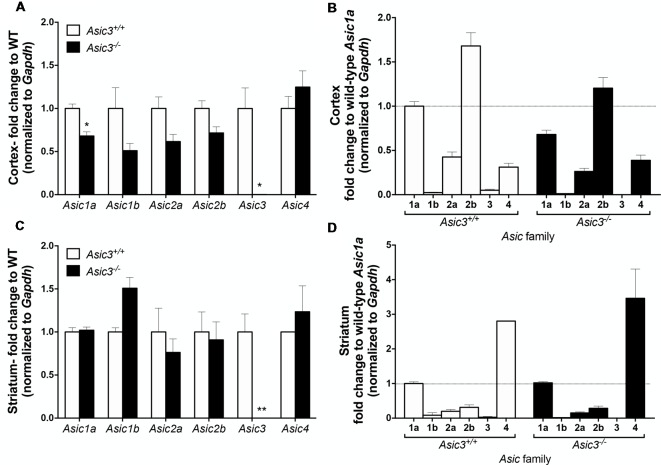
The gene expression of Asic subtypes in the cortex and striatum of Asic3+/+ and Asic3−/− mice. The gene expression of Asic1a, 1b, 2a, 2b, 3 and 4 were analyzed by quantitative real-time polymerase chainreaction (qRT-PCR) in each brain region in each genotype. (A) Compared to the Asic3+/+ control for each gene, Lower expression of Asic1a and Asic3 were detected in the cortex of Asic3−/− mice. No difference was detected in other Asic subtypes between Asic3+/+ and Asic3−/− mice in the cortex. N = 3 mice per group. *p < 0.05 vs. Asic3+/+. (B) Compared to the WT Asic1a control for each genotype. The distribution of Asic subtypes in the cortex of Asic3+/+ and Asic3−/− mice. N = 3 mice per group. (C) Compared to the Asic3+/+ control for each gene, Lower expression of Asic3 were detected in the striatum of Asic3−/− mice. No difference was detected in other Asic subtypes between Asic3+/+ and Asic3−/− mice in the striatum. N = 3 mice per group. *p < 0.05, **p < 0.01 vs. Asic3+/+. (D) Compared to the WT Asic1a control for each genotype. The distribution of Asic subtypes in the striatum of Asic3+/+ and Asic3−/− mice. N = 3 mice per group. Data are mean ± SEM. Data analyzed by two-tailed unpaired t-test.